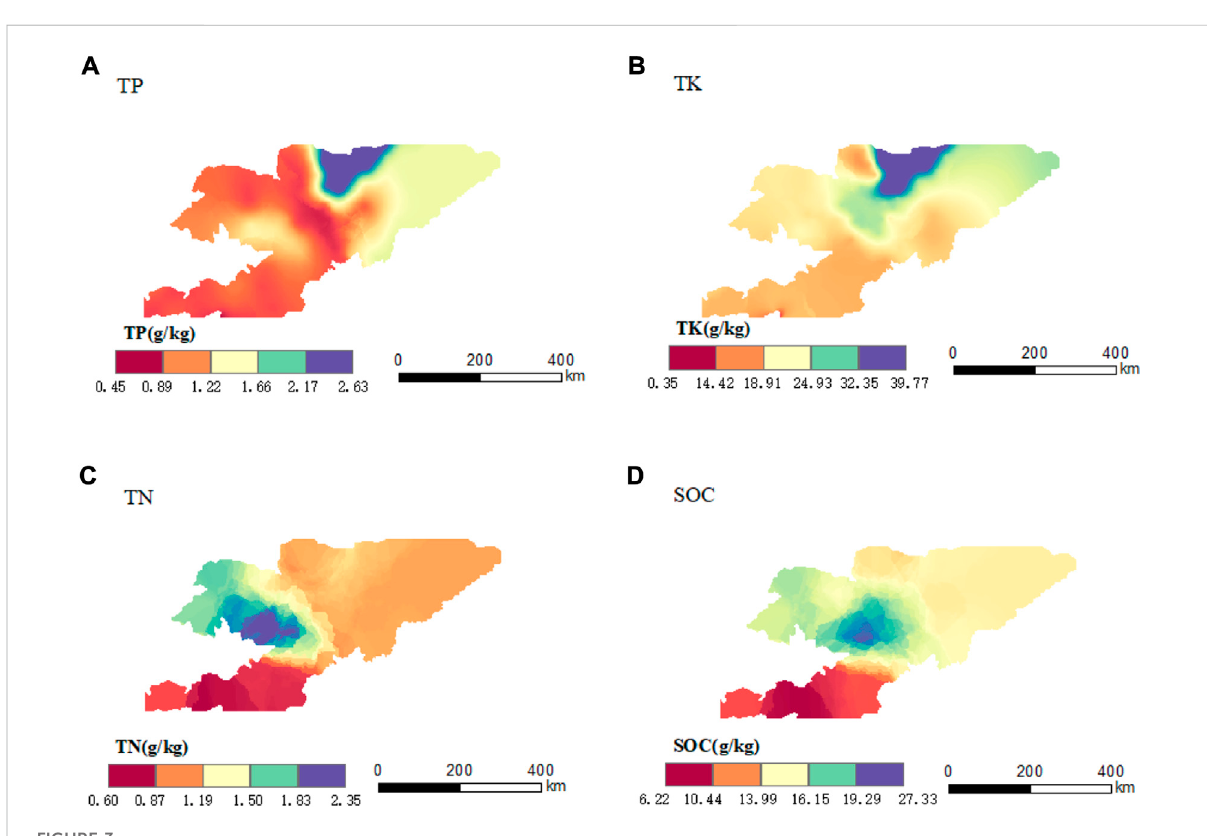
(Figure 3). Based on the optimal spatial interpolation of SOC, TN, TP, and TK for the entire soil surface in Kyrgyzstan using the ordinary kriging method, the spatial distribution of SOC, TN, TP, and TK contents in soil was mapped, with the SOC content within the range of 13.99 – 16.15 g/kg and an average of 14.80 g/kg. The average concentrations of TP and TK in the study area were 0.96 g/kg and 17.87 g/kg, ranging from 0.89 to